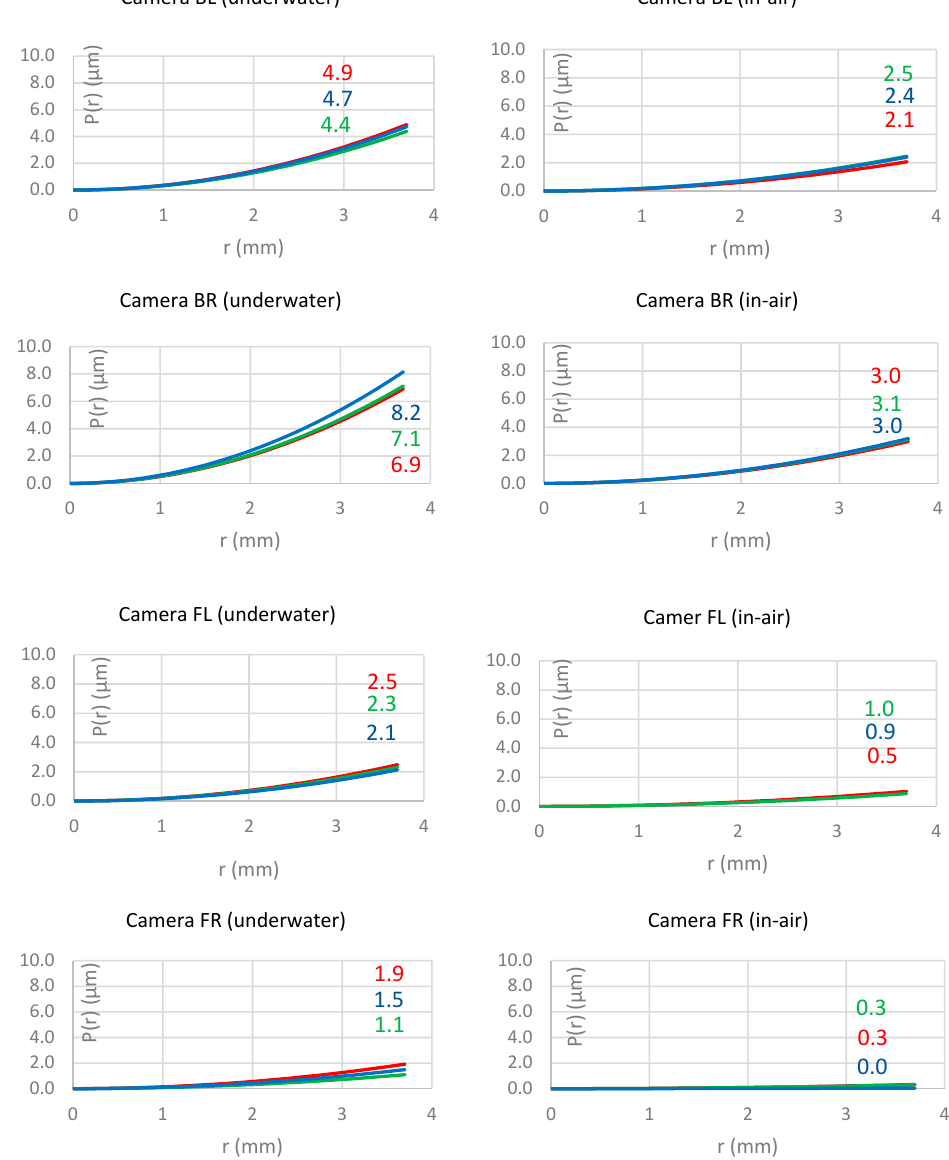
Figure 8. Comparison of the influence of the calculated decentering lens distortion parameters for the four different cameras (rows) in underwater ( left column) and in-air environment ( right column). The colours indicate the results for the different bands (blue, green, red). Black indicates that the bands are so close to each other that the difference cannot be shown. The numbers indicate the distortion in µm at the maximum radial distance.